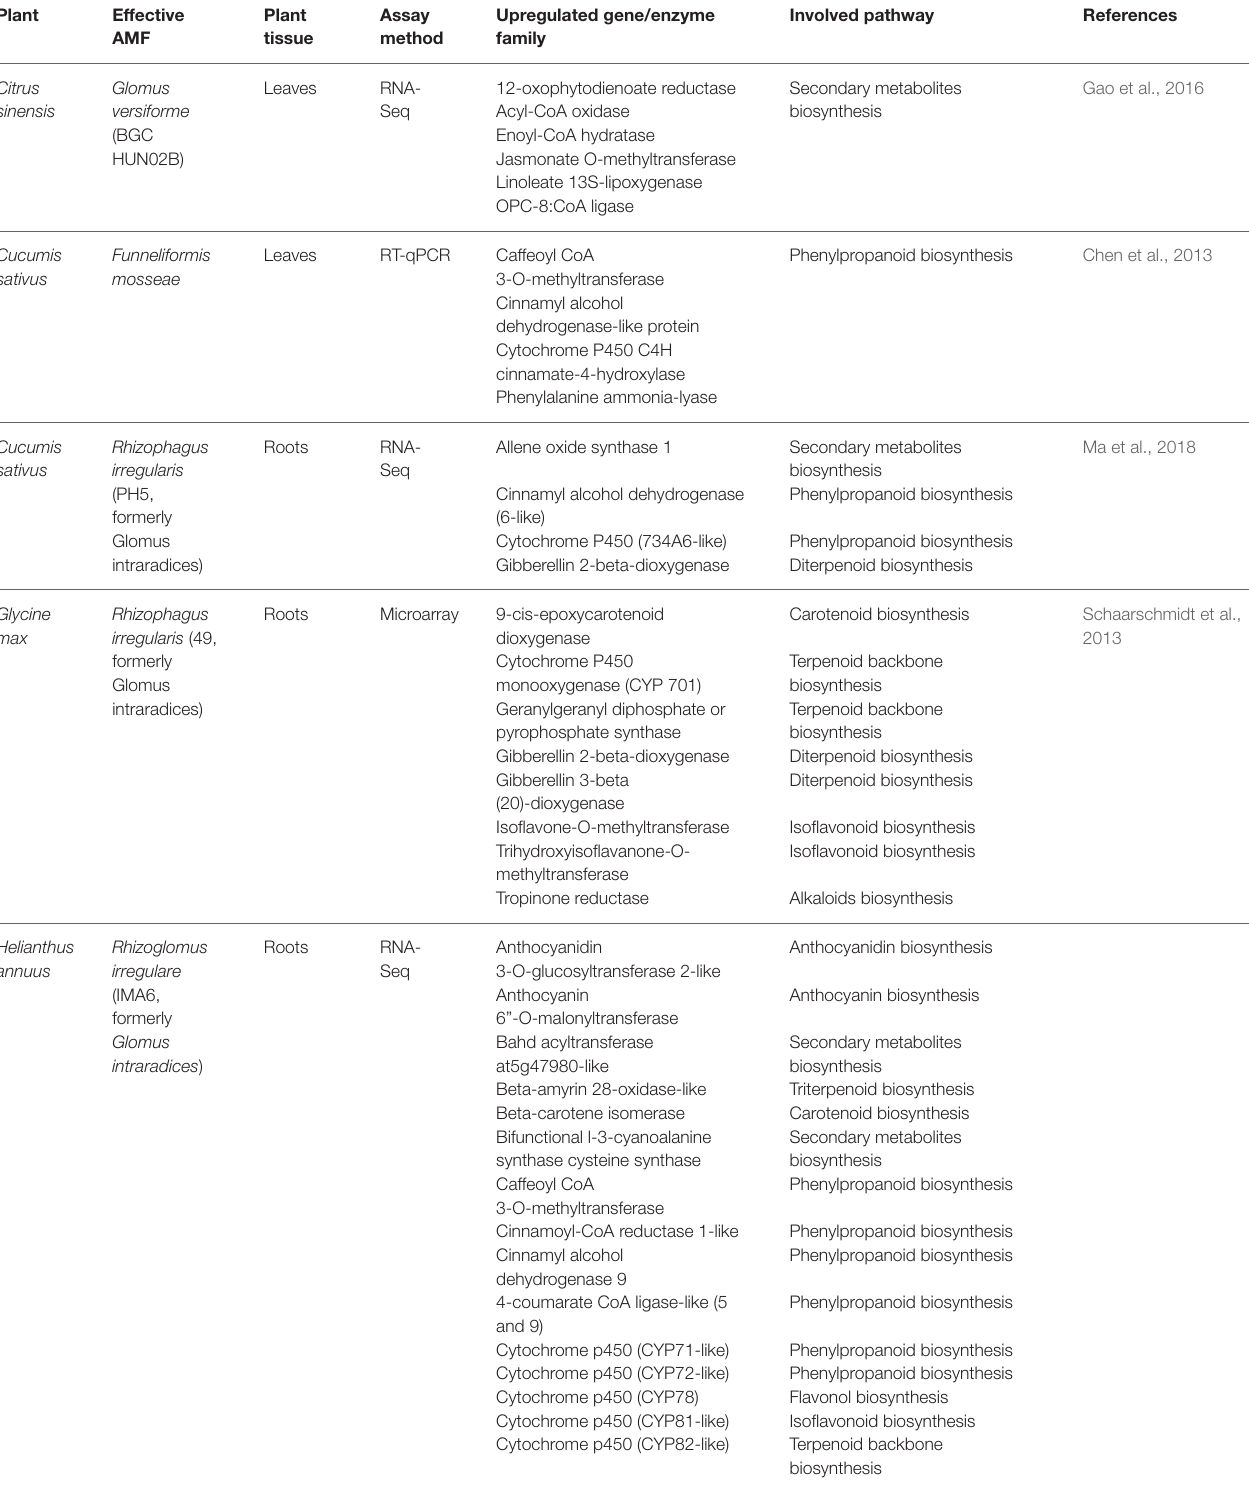
TABLE 2 | Genes involved in the biosynthesis of health-promoting secondary metabolites, which are upregulated in above- or belowground cell tissues of mycorrhizal food plants.